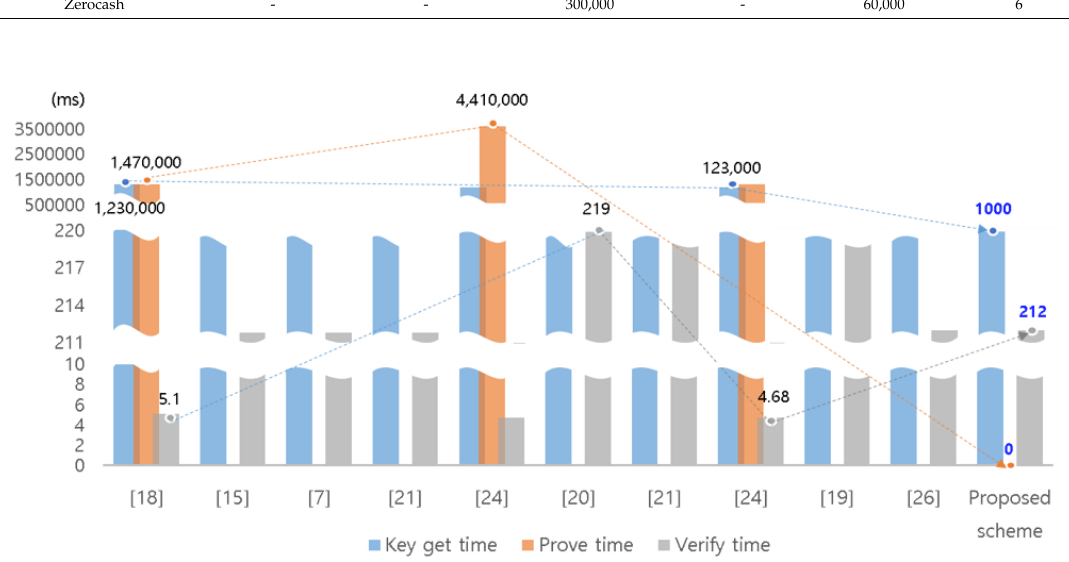
Figure 7. Comparison of efficiencies with various times for the existing scheme and our